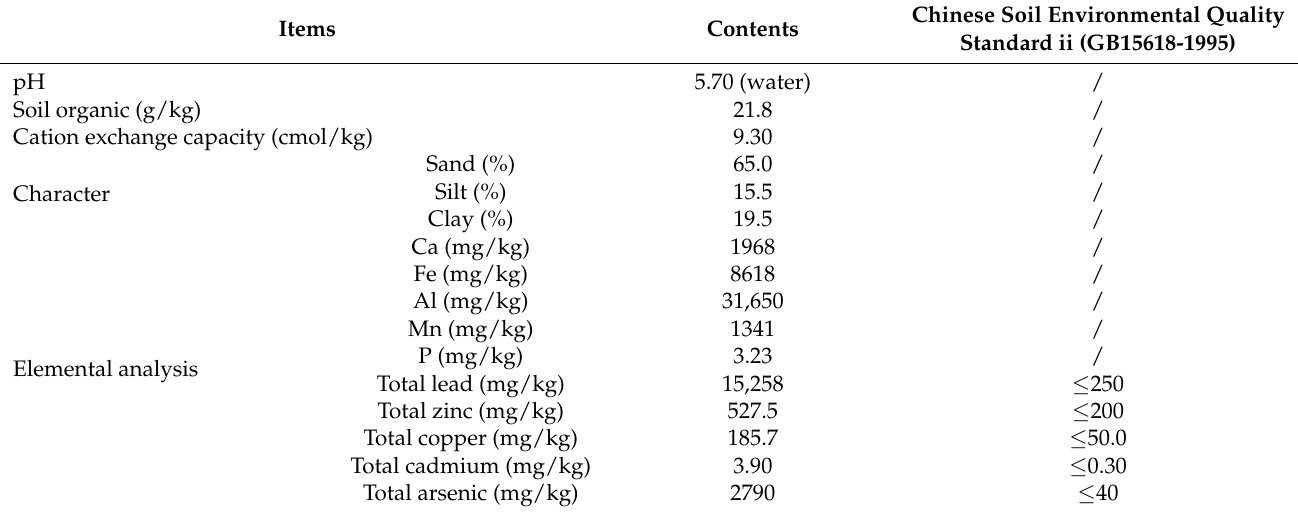
Table 1. Physical and chemical properties of the tested soil